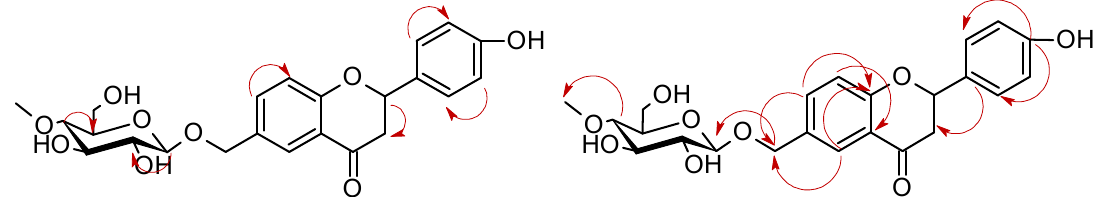
Scheme 6. Key COSY (on the left) and HMBC (on the right) correlations for the structure elucidation of product 4b . product 4b .